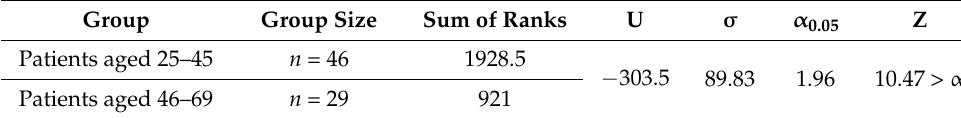
Table 1. Mann–Whitney U test for patients aged 25–45 ( n = 46) and 46–69 ( n = 29).